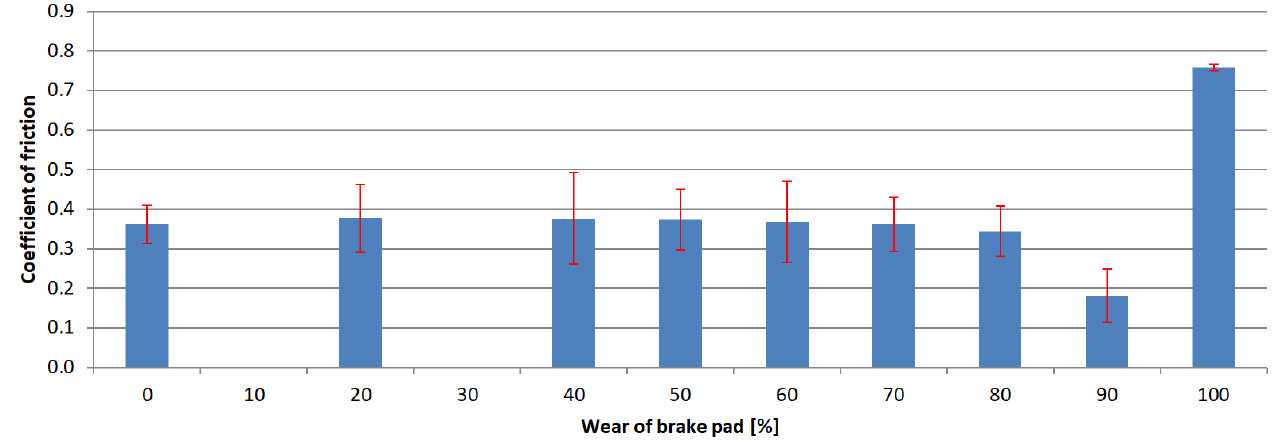
10 of 17 Figure 7. Coefficient of friction values of samples obtained from 2nd brake pad group.